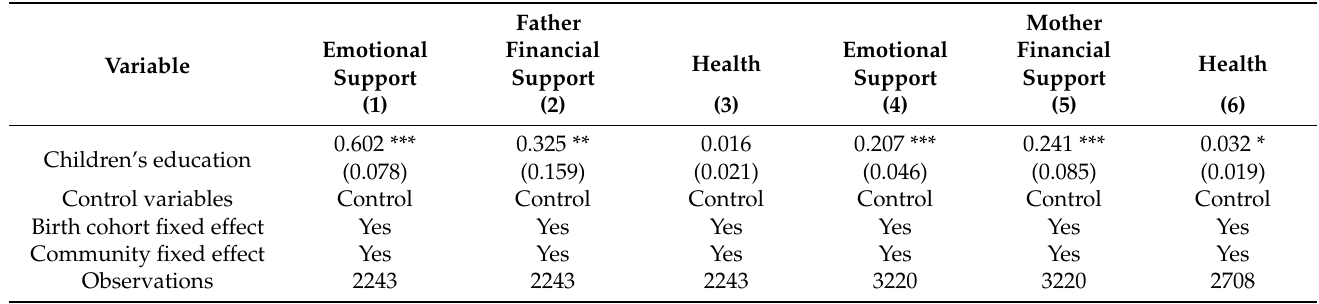
Table 6. Results of the mechanism analysis.